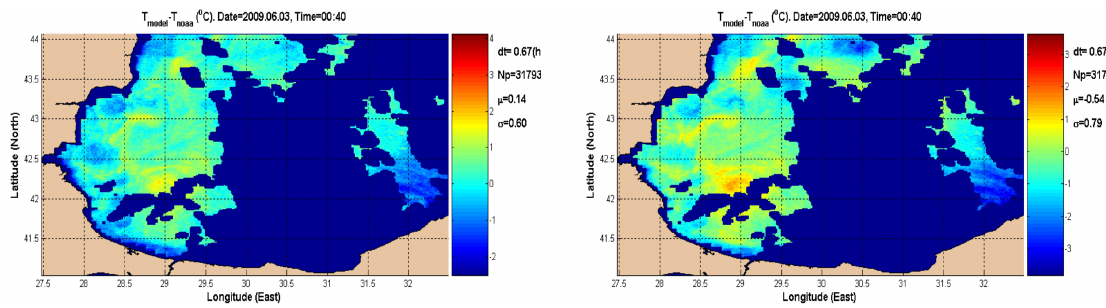
Fig. 16. The same as in Fig. 15 but for the south-western corner of the Black